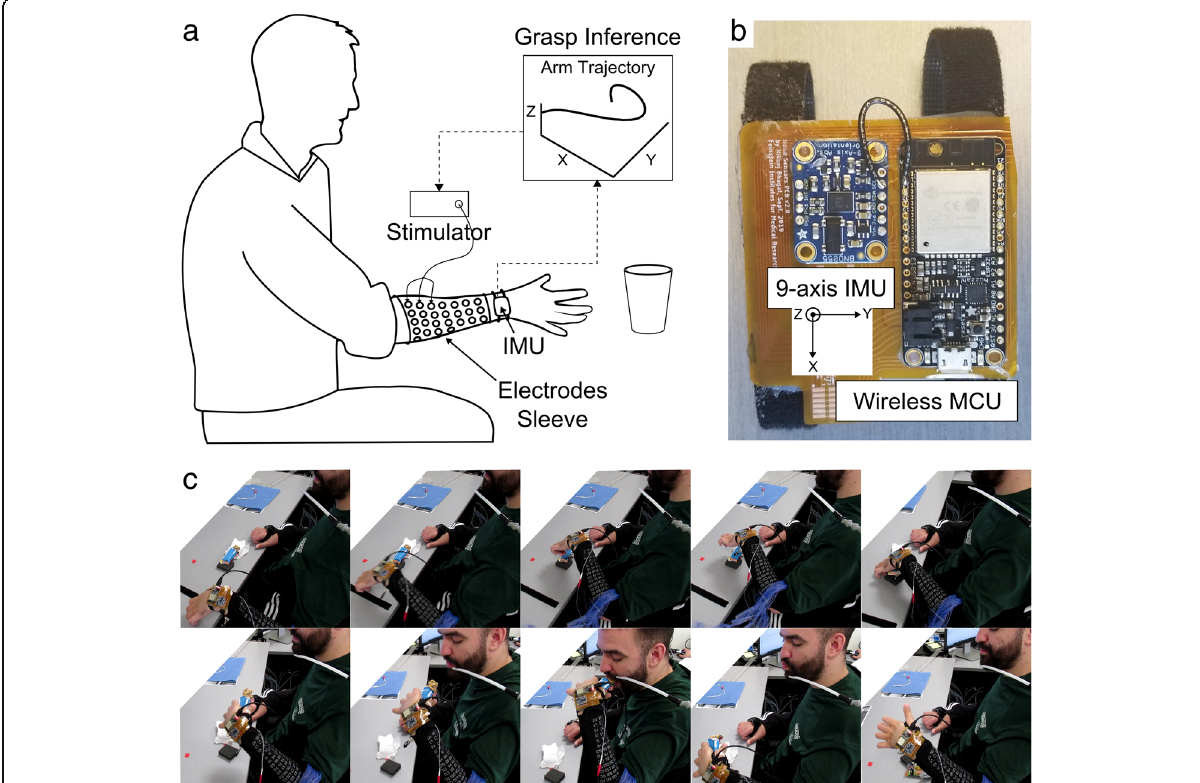
Fig. 1 a Experimental setup for utilizing reaching movements and enable grasping through the use of an IMU and textile-based electrodes. b Closeup of custom-built IMU sensor module with microcontroller (battery not shown). c Still images showing an SCI participant using the IMU to activate neuromuscular stimulation and eat a granola